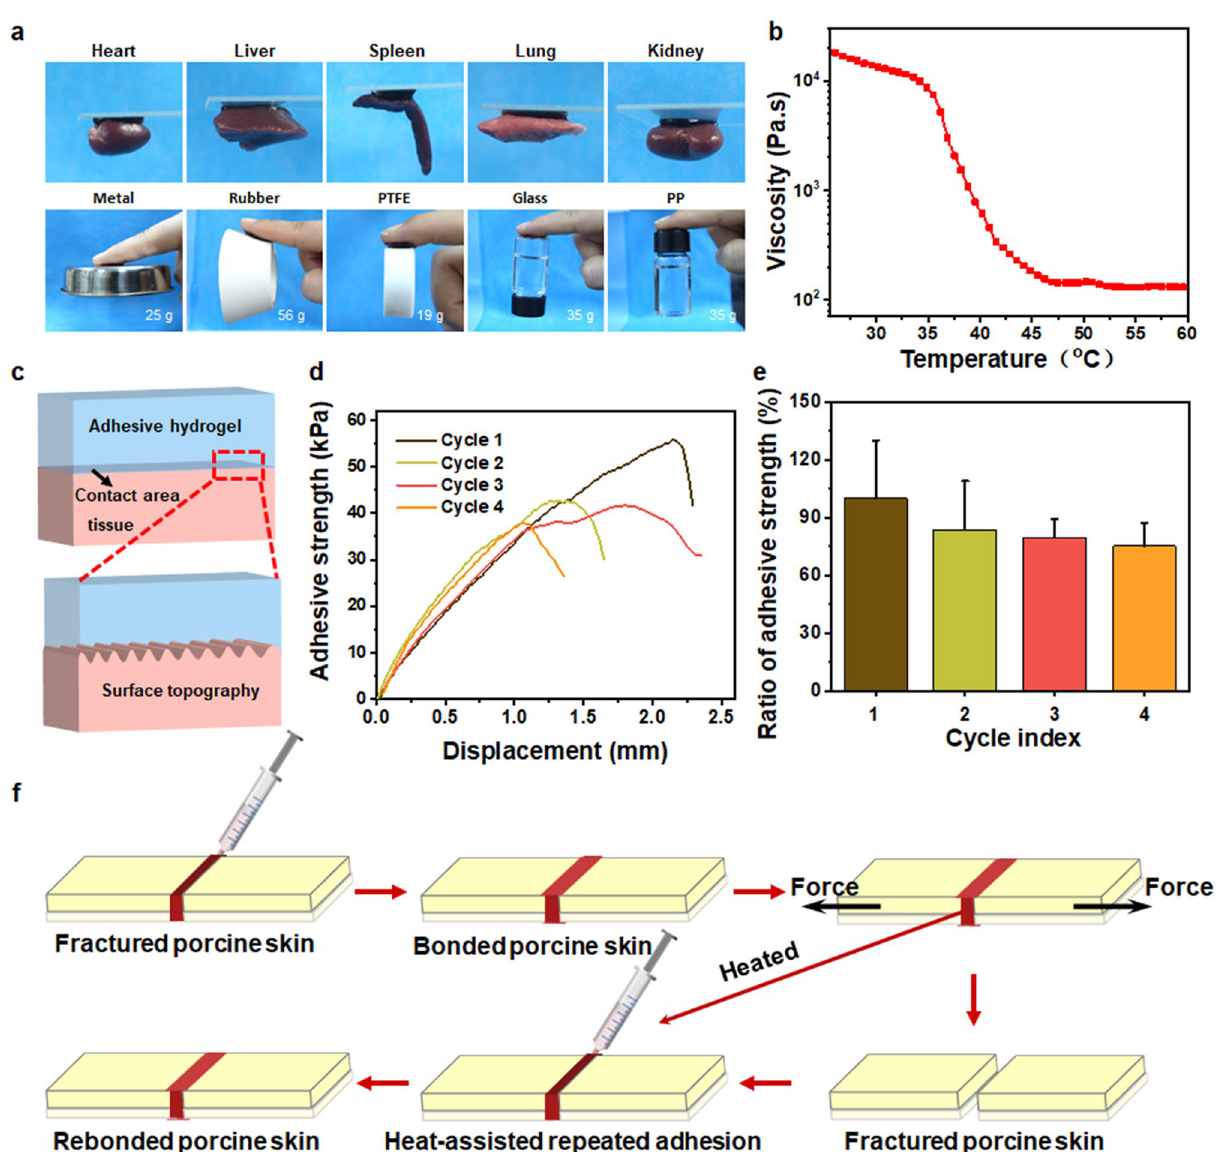
Fig. 6 Adhesive properties of the hydrogel. a Presentations of the hydrogels adhered to different surfaces of the tissues or materials. b Temper- ature-dependent viscosity of hydrogel GT-SA-TPF 20 . c Illustration of the adhesive hydrogel in full contact with the surface of the tissues at body temperature. d Adhesive strength-displacement curves and e the ratio of adhesive strength of the repeated bonding cycles. f Illustration of the repeated temperature-responsive bonding of skin